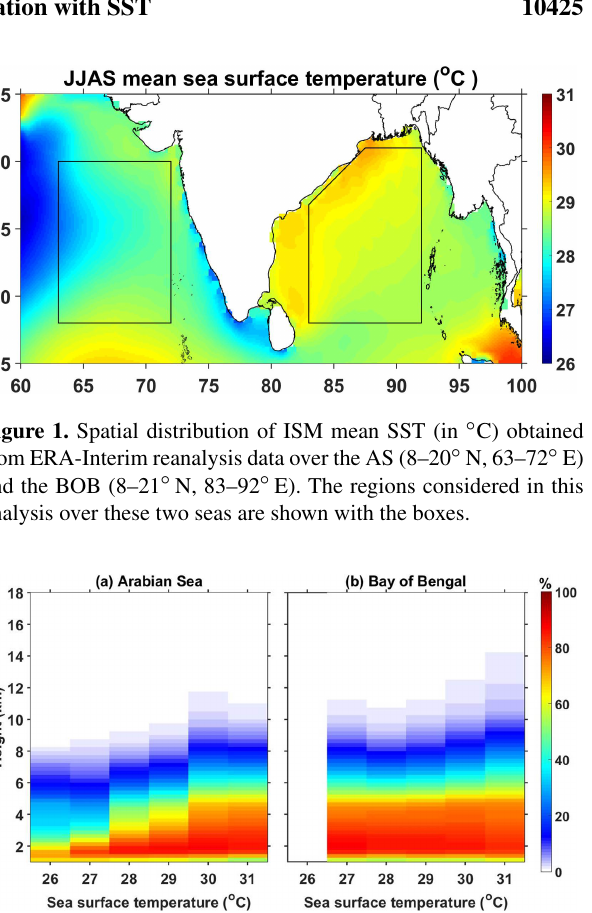
Figure 2. (a) and (b) represent the altitudinal distribution of occur- rence of conditional reflectivity ( ≥ 17dBZ) as a function of SST with respect to precipitation occurrence at that particular SST inter- val over the AS and the BOB,